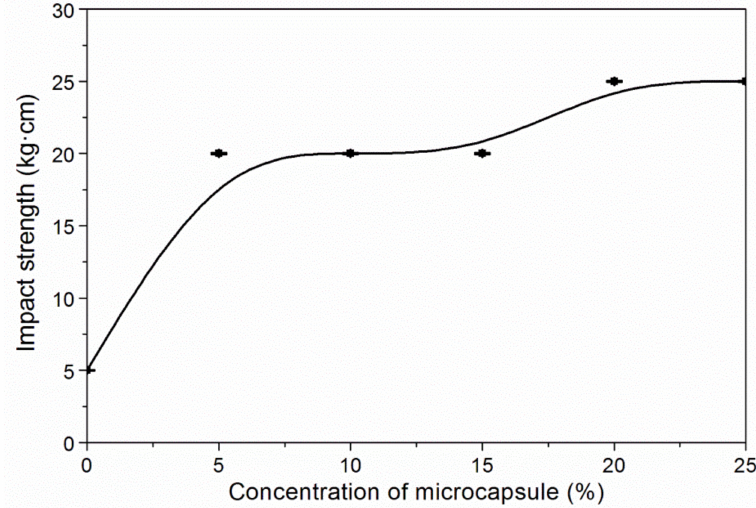
Figure 9. E ff ect of di ff erent concentration of microcapsules on impact resistance of waterborne